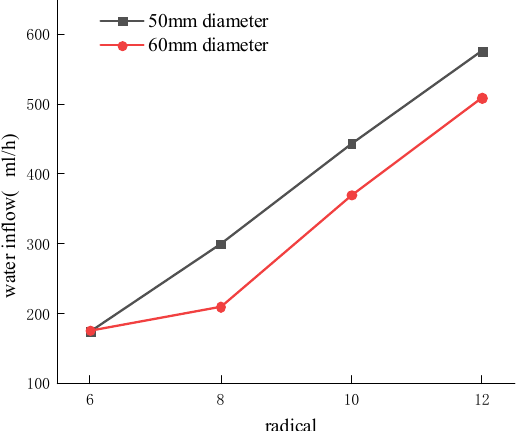
Figure 21. The comparison of seepage flow of the fiber bundles with different pipe diameters.